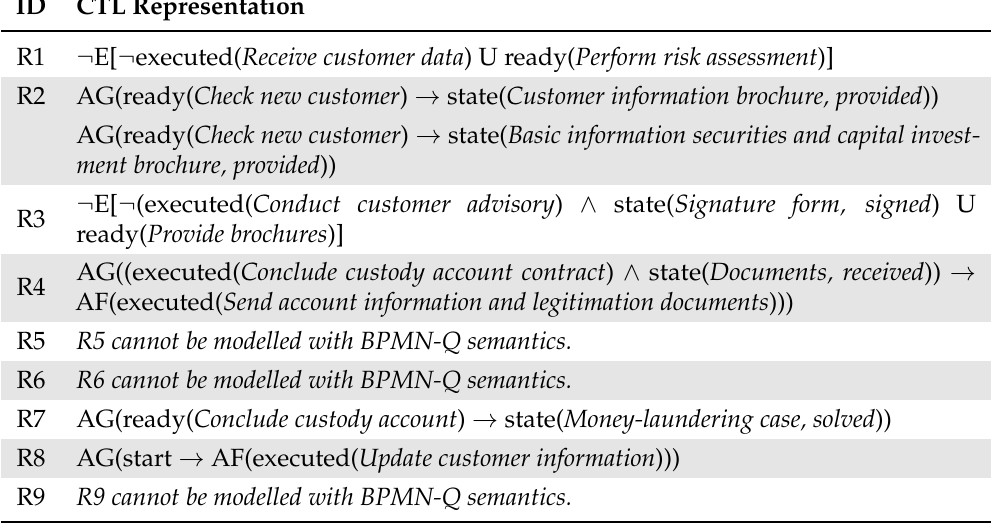
Table 5. Mapping of formalised requirements from BPMN-Q to CTL